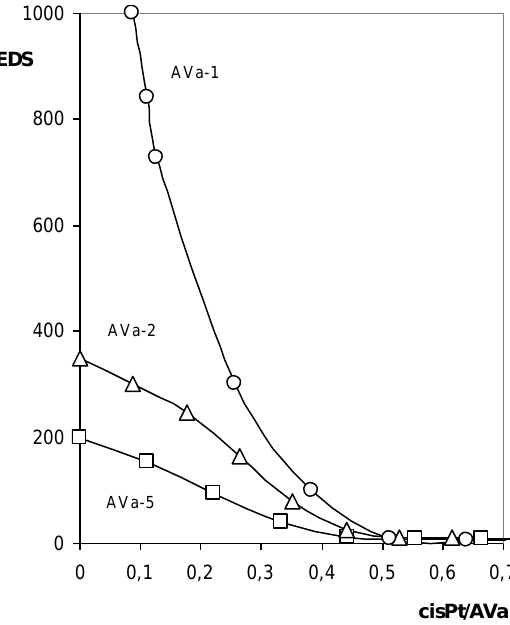
Figure 7. Equilibrium degree of swelling (EDS) of the hydrogels (AVa-1, AVa-2 and AVa-5) in relation to the cisPt/AVa molar ratios in deionized water at 25